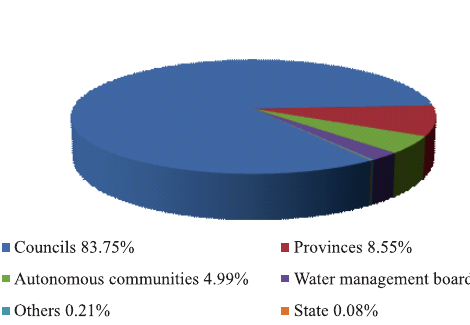
Fig. 2. Distribution of the Spanish low-volume road system according to governing authorities